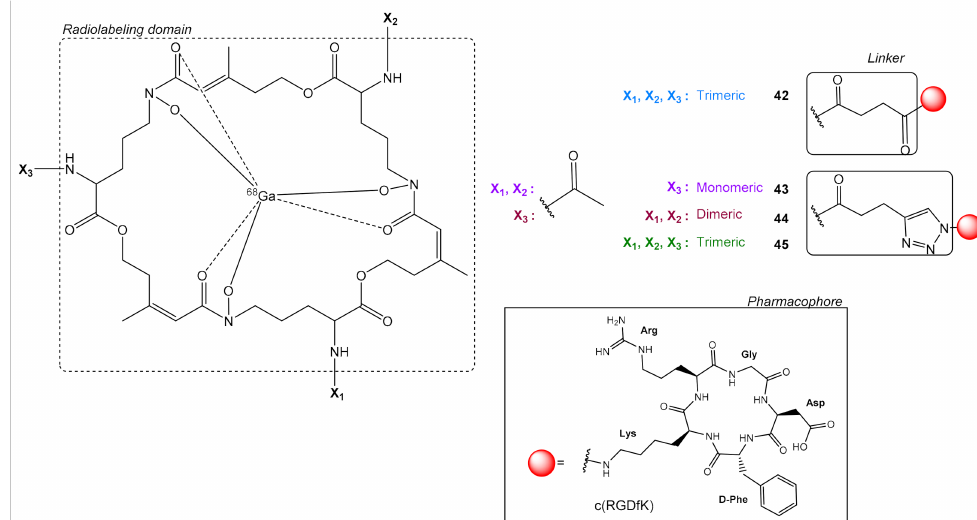
Figure 12. Chemical structures of conjugates between the natural chelator fusarinine C (FSC) and c(RGDfK) pharmacophores, [ 68 Ga]Ga-FSC-[E-c(RGDfK)] 3 42 , [ 68 Ga]Ga-FSC-(CH 2 )-Tz-c(RGDfK) 43 , [ 68 Ga]Ga-FSC-[(CH 2 )-Tz-c(RGDfK)] 2 44 , [ 68 Ga]Ga- FSC-[(CH 2 )-Tz-c(RGDfK)] 3